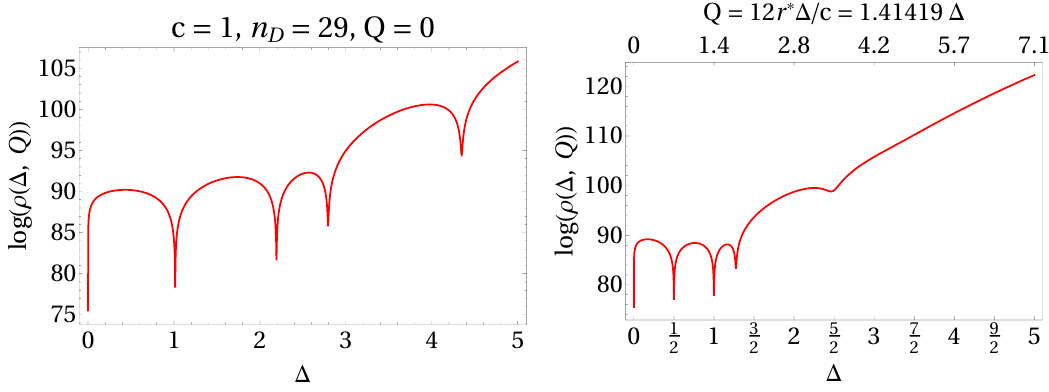
Figure 8 . The functional restricted at Q = 0 is shown on the left. The states that saturate the best bound on 8 G N m is shown on the right. Q